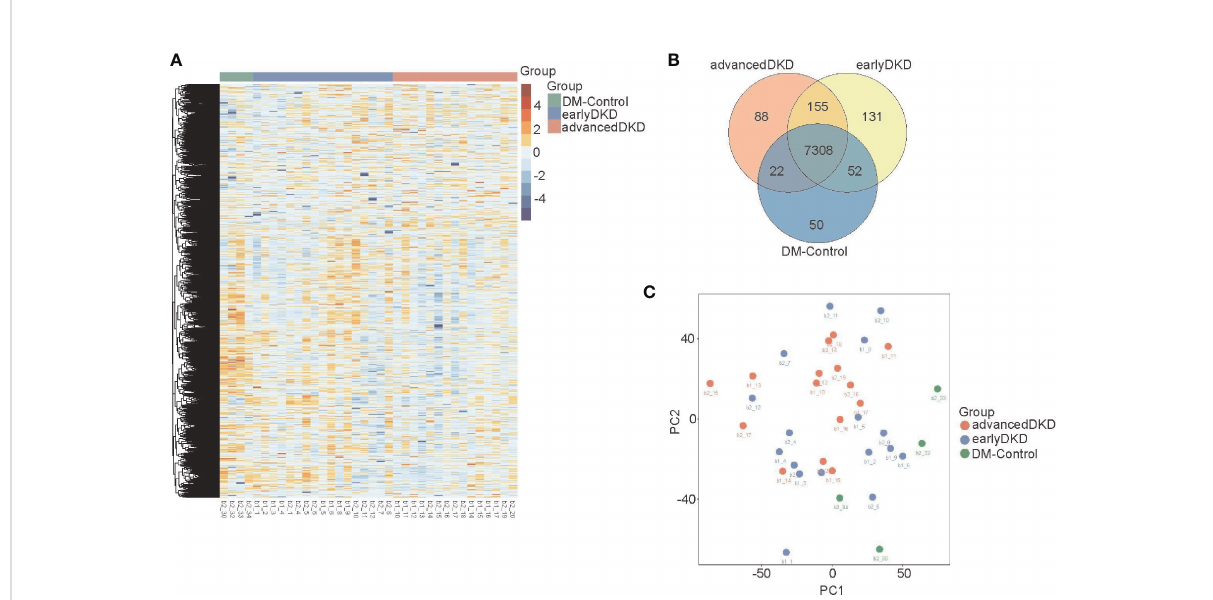
FIGURE 2 Renal tissue proteome pro fi les. (A) Heatmap showing 9205 protein that were expressed in the renal tissue of patients with DM control, early DKD, or advanced DKD. (B) Venn diagram showing overlapping protein expression among the three groups. (C) PCA of the 9205 proteins from the three groups. DM: diabetes mellitus; DKD: diabetic kidney disease. PCA: Principal component